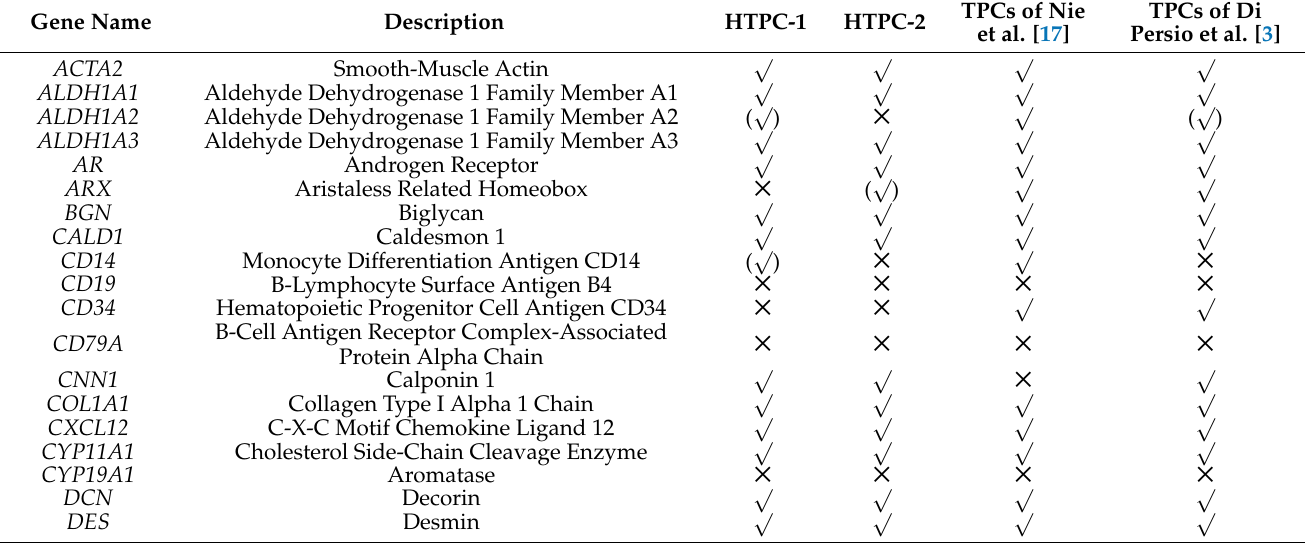
Table A3. Transcript comparison of our data (HTPC-1/HTPC-2) with the data of Di Persio et al. [3] √ and Nie et al. [17]. indicates expression, (cid:53) indicates absence, weak